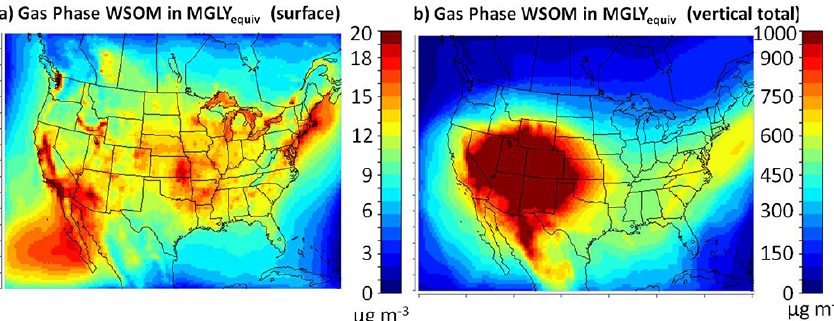
Fig. 2. MGLY equiv mass concentrations for gas-phase water-soluble organic matter (WSOM) at the surface (a) and for the model column (surface to 100mb) (b) . Note that all species included in Table 1 are used in the calculation of MGLY equiv . Values are July 2003 averages.